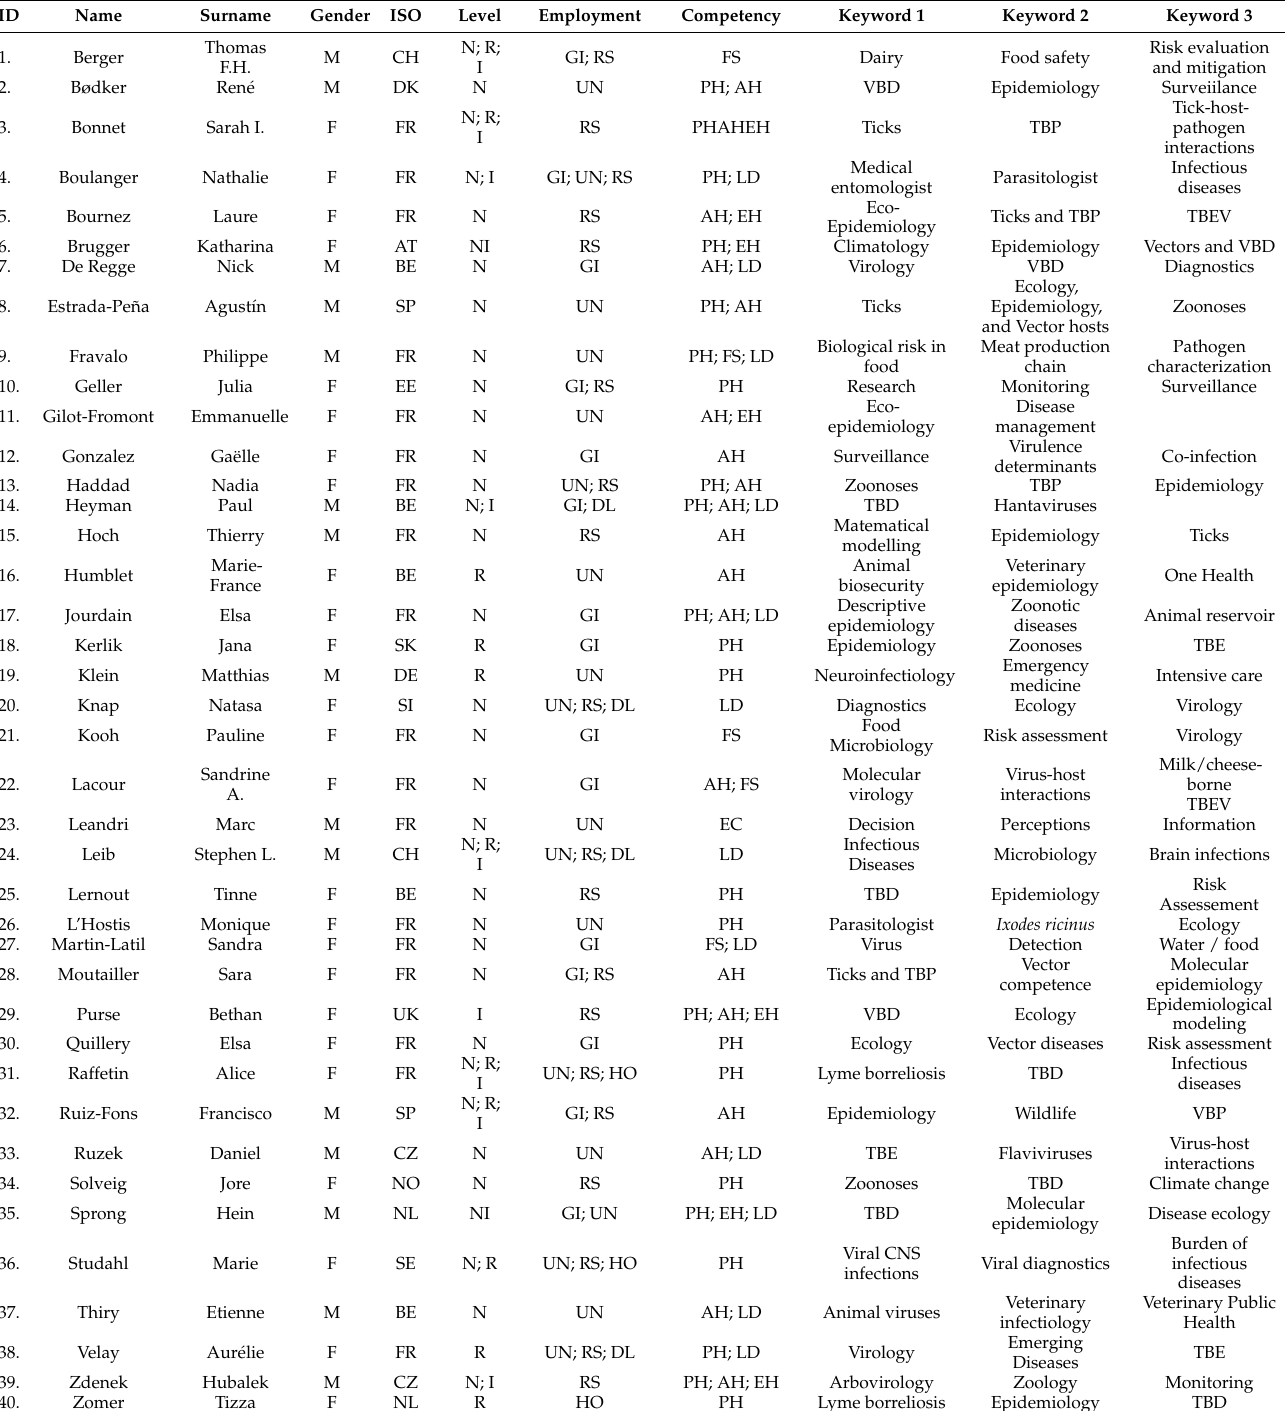
Table A2. Profiles of Experts Involved in the Elicitation of Knowledge, in alphabetic order (N =